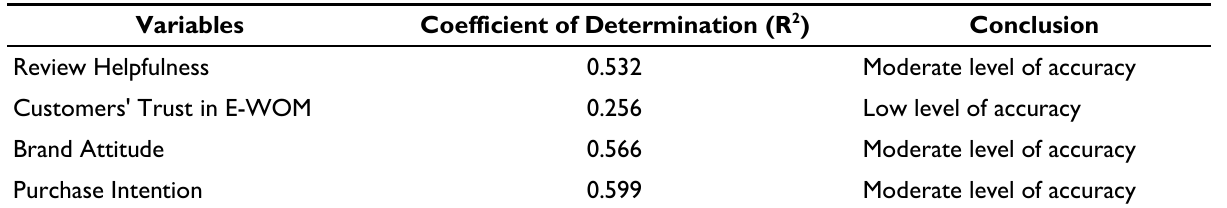
Table 5. Coefficient of Determination Testing Result